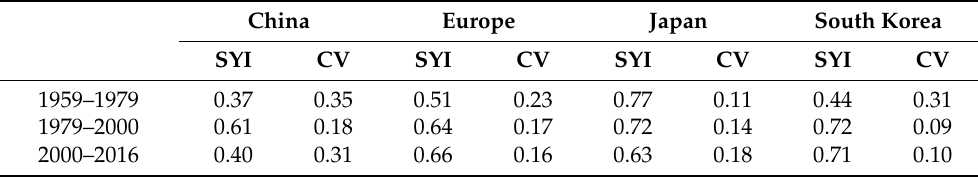
Table 4. The sustainability of the cultivated buckwheat yield from 1959 to